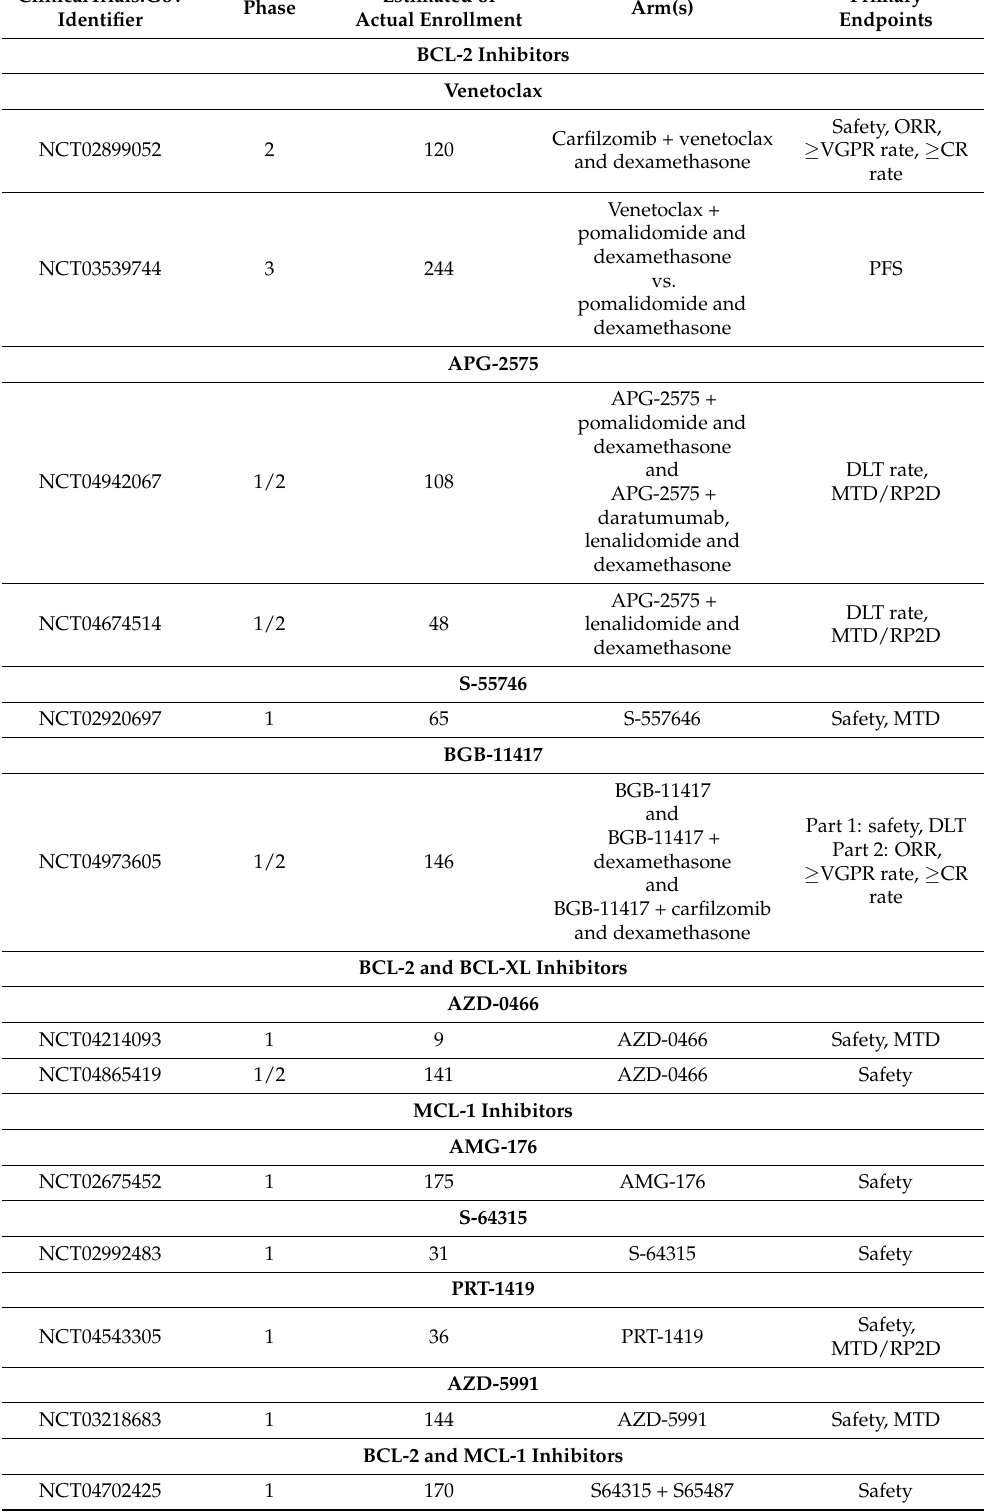
Table 1. Ongoing clinical trials with Bcl-2-family inhibitors in relapsed refractory multiple myeloma. ClinicalTrials.Gov